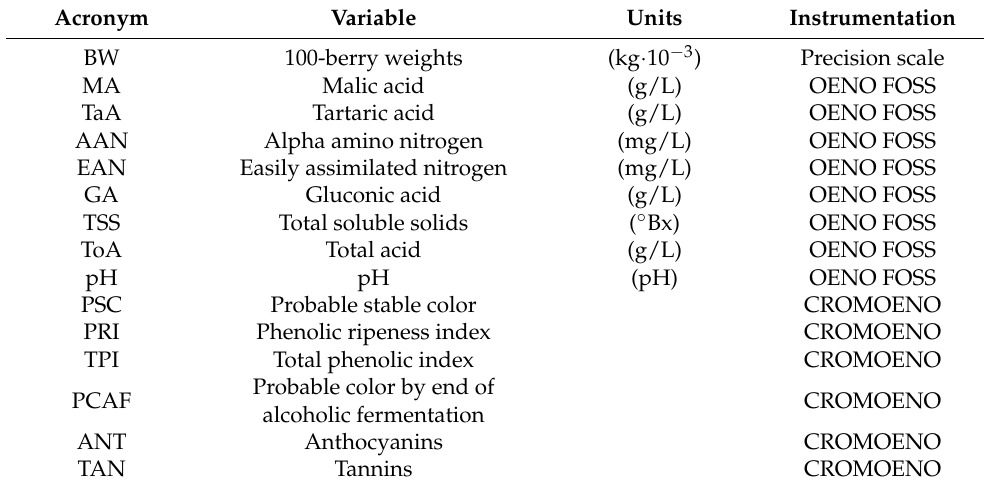
Table 1. Fifteen laboratory-analyzed must quality variables.